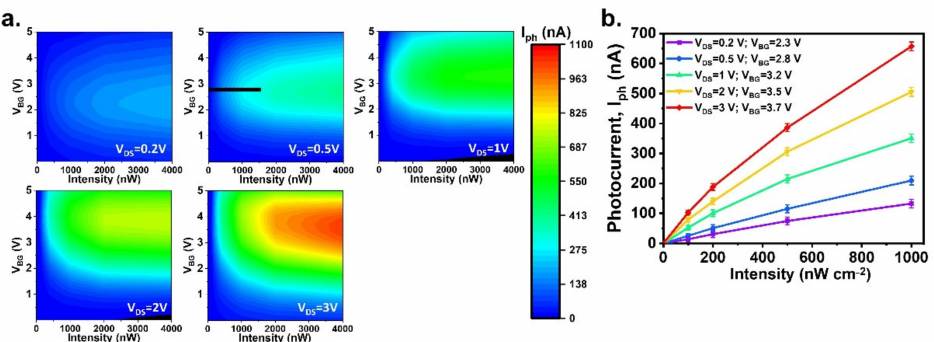
Figure 5. ( a ) The photocurrent at a wavelength of 450 nm plotted as functions of V BG and light intensities, for V DS at 0.2 V, 0.5 V, 1 V, 2 V, and 3 V. The color scale bar is shown on the right. ( b ) The photocurrent as a function of light intensity. It shows a linear dependence at V DS 0.5 V and V BG = 2.8